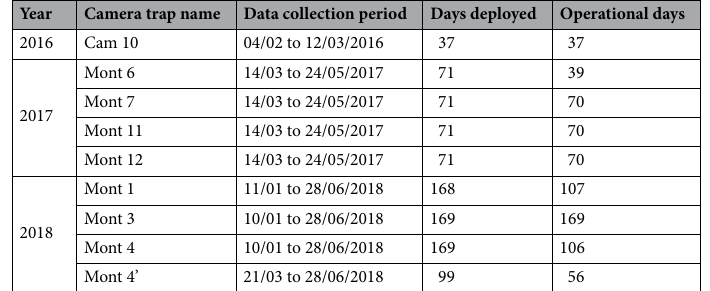
Table 1. Camera traps which recorded the Western Derby elands in the Niokolo Koba National Park (Senegal), and their operation days during 2016, 2017 and